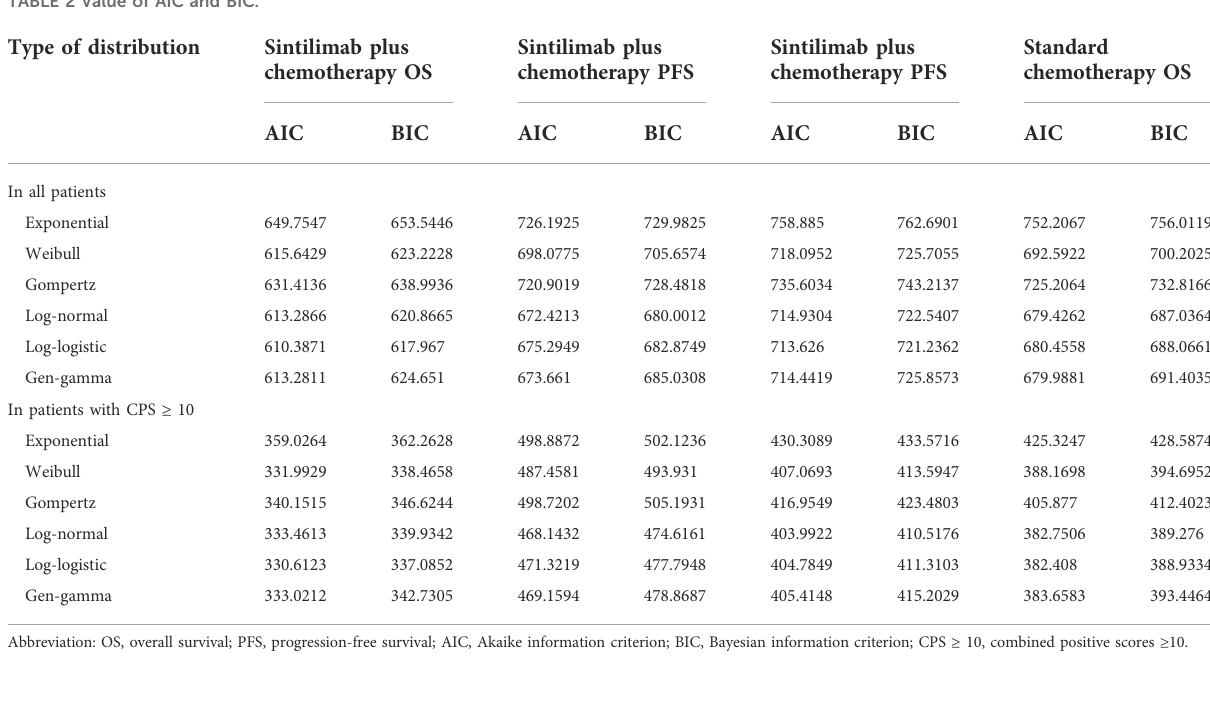
TABLE 2 Value of AIC and BIC.